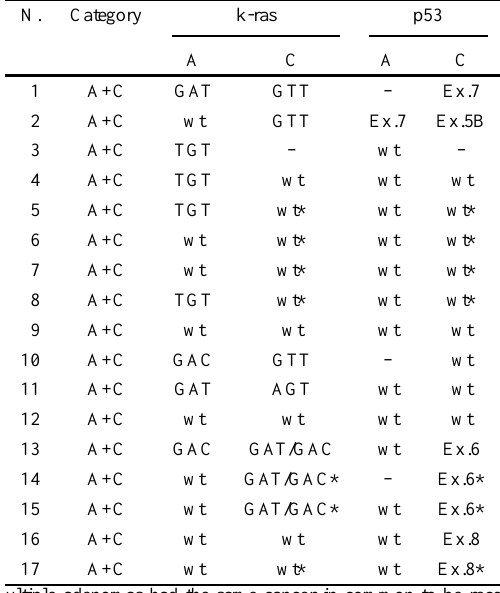
Analysis of k-ras and p53 mutations for 17 human colorectal ade- nomas having cancer in the near vicinity